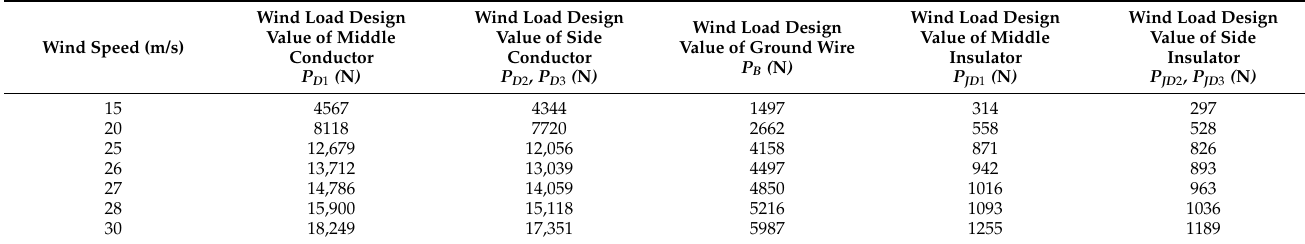
Table 4. Wind load of conductor, ground line, and insulator.